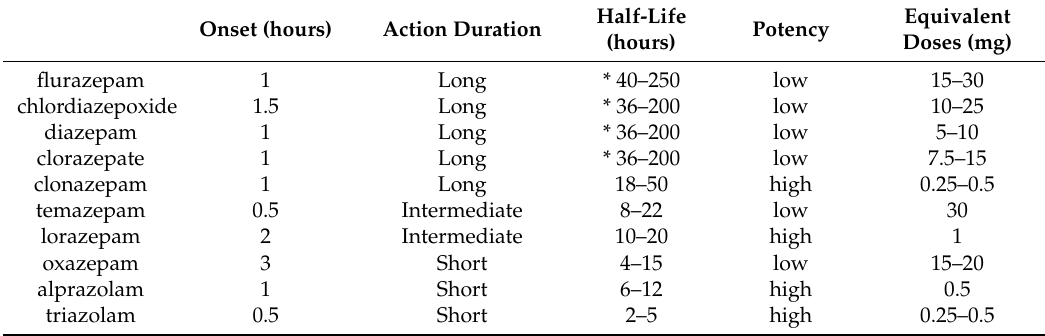
Table 2. Approximate benzodiazepine characteristics and equivalent doses (therapeutic equivalent doses are approximate due to clinical potency varying between